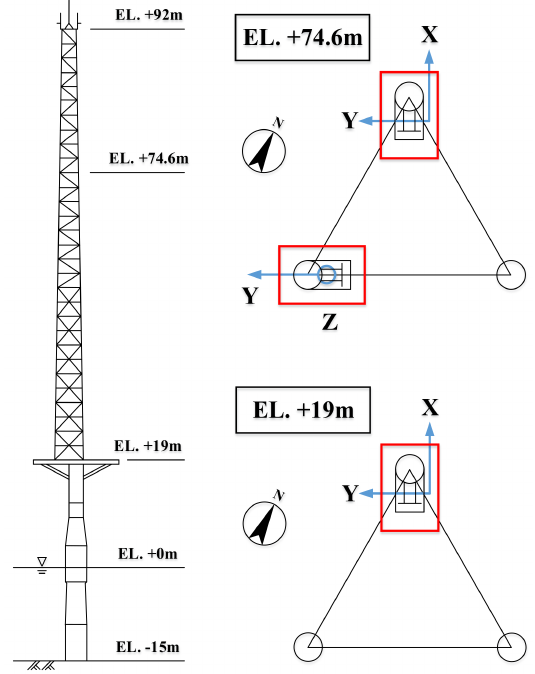
Figure 2. Schematic for TPC’s met mast and the positions of accelerometers. Two two-axis accelerometers oriented in the X–Y and Y–Z directions were installed on the met mast at a height of 74.6 m above the MWL. Another two-axis accelerometer (X–Y) was installed at the height of the platform (19 m above the MWL) (Figure 2). The sampling frequency of the